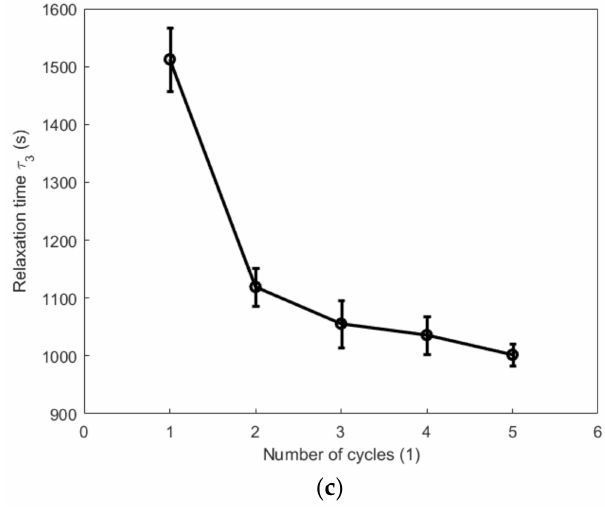
Figure 18. Evolutions of relaxation times τ 1 , τ 2 , and τ 3 with respect to the number of cycles during the cyclic compression process: ( a ) τ 1 ; ( b ) τ 2 , and ( c ) τ 3